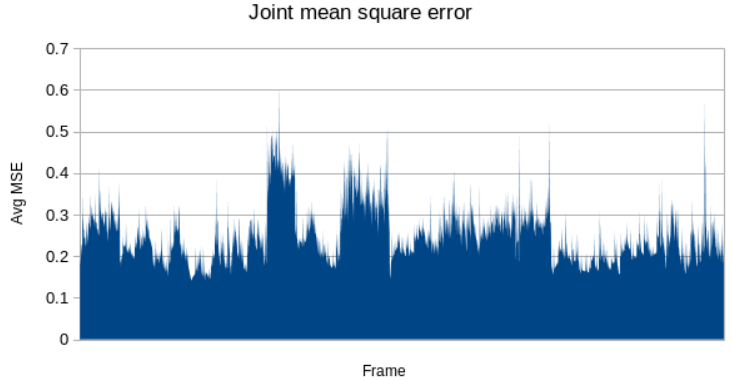
Figure 11. Skeleton IK joint MSE accross video-frame sequence of an exercise. The average OKS value achieved is 0.989, while its breakdown by exercise can be seen in Figure 12.